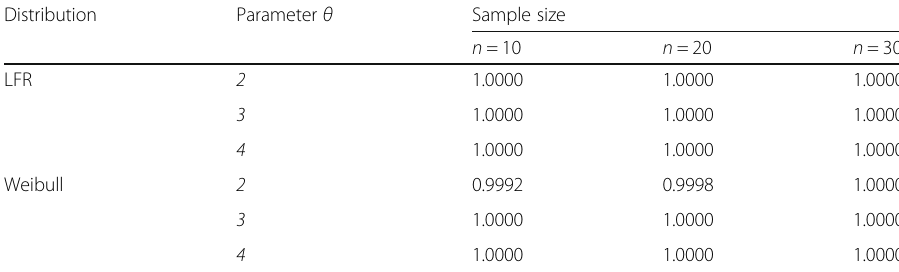
Table 5 Power estimates of the statistic ^ Δ c ð s Þ Distribution Parameter θ Sample